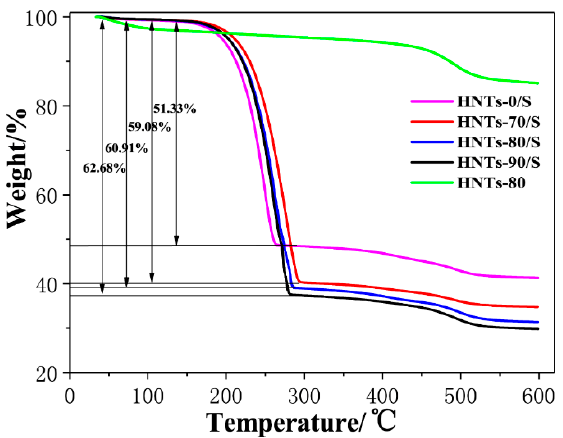
/ S composites with di ff erent etching Figure 4. The TG curves of HNTs-80 and HNTs/S composites with different etching temperature. Figure 4. The TG curves of HNTs-80 and HNTs